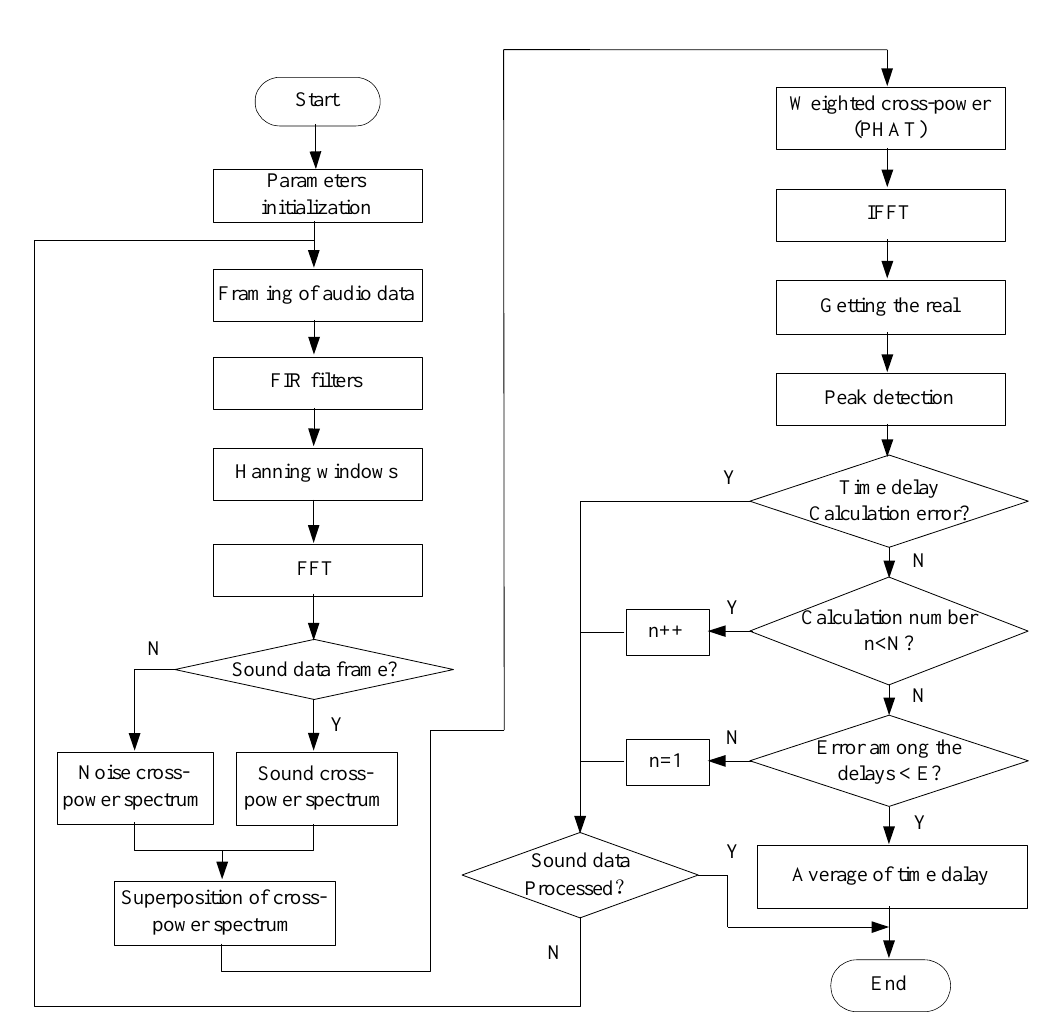
Figure 6. Flowchart of